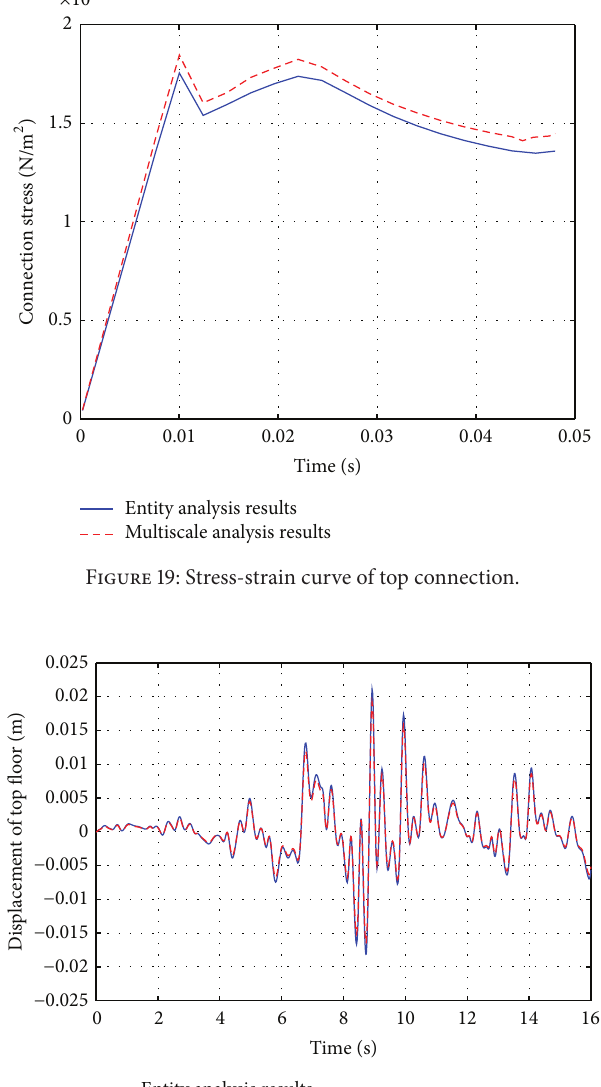
Figure 22: Stress of frame with weakened